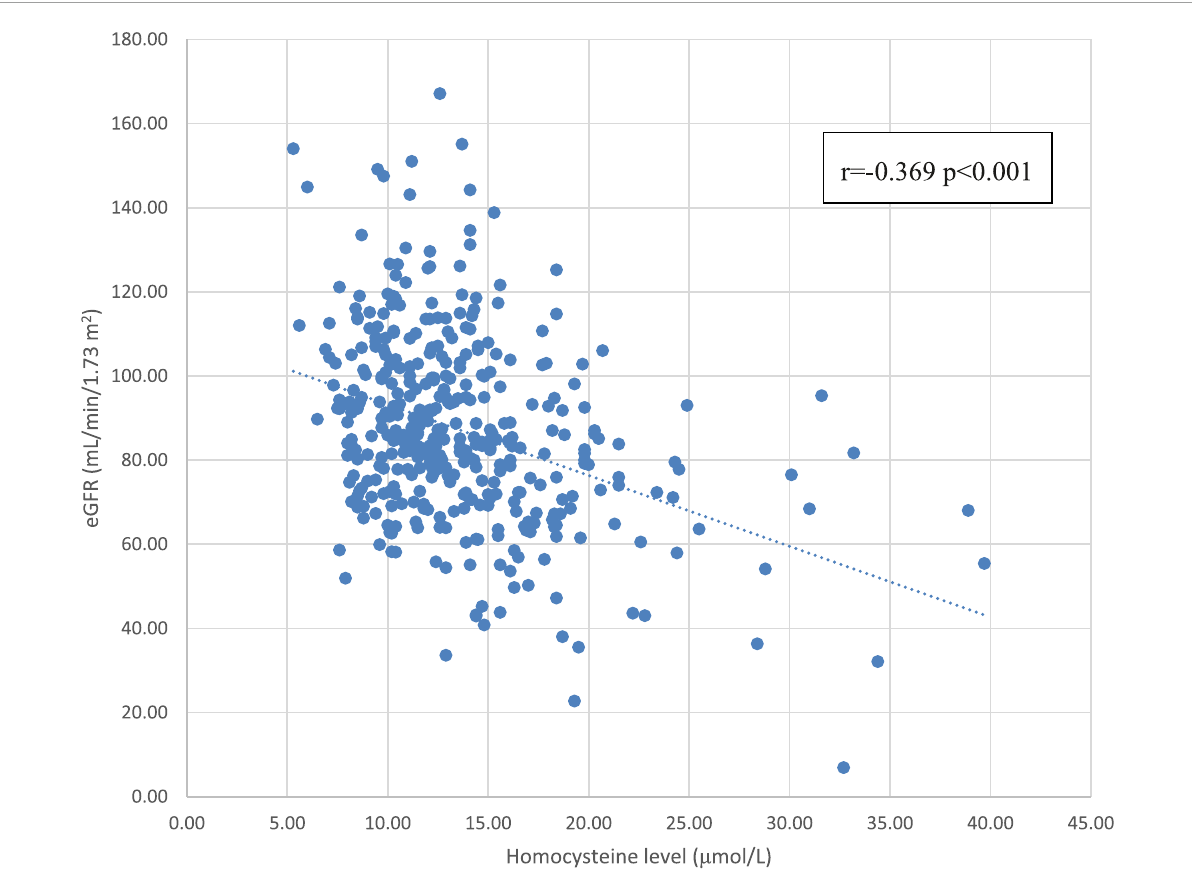
FIGURE1 The correlation between the homocysteine level and eGFR. Abbreviations: eGFR, estimated glomerular filtration